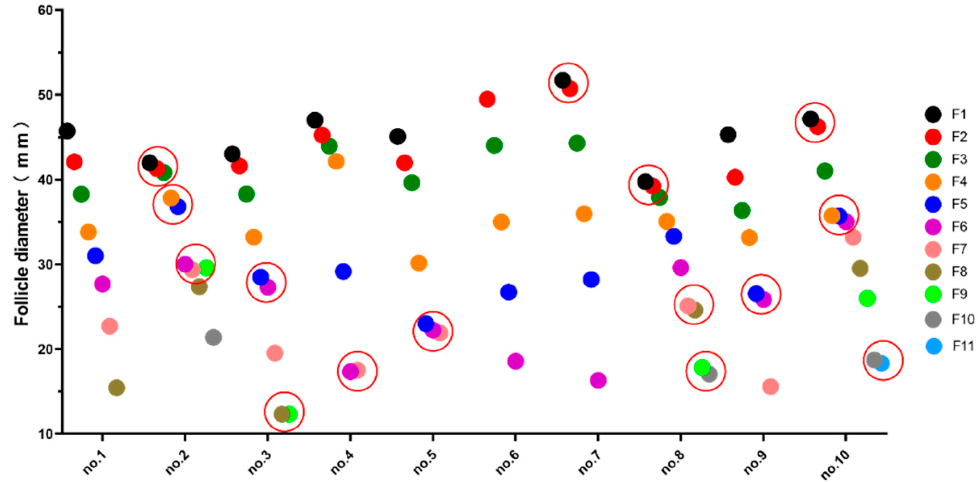
Figure 3. Follicular diameter in the first egg-laying cycle of the Zhedong white goose. The follicles enclosed within the circles are supposed to develop to produce double-yolked